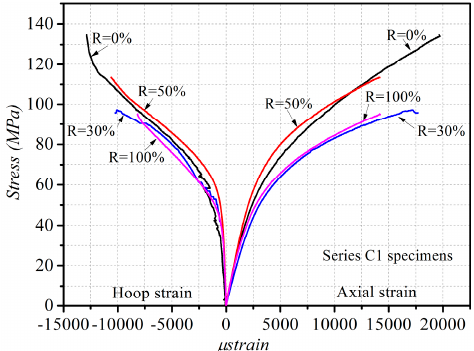
Figure 5. Effect of replacement ratio on stress–strain curve of CFRP-confined RAC (R = 0%, 30%, 50%, 100% in series C1).